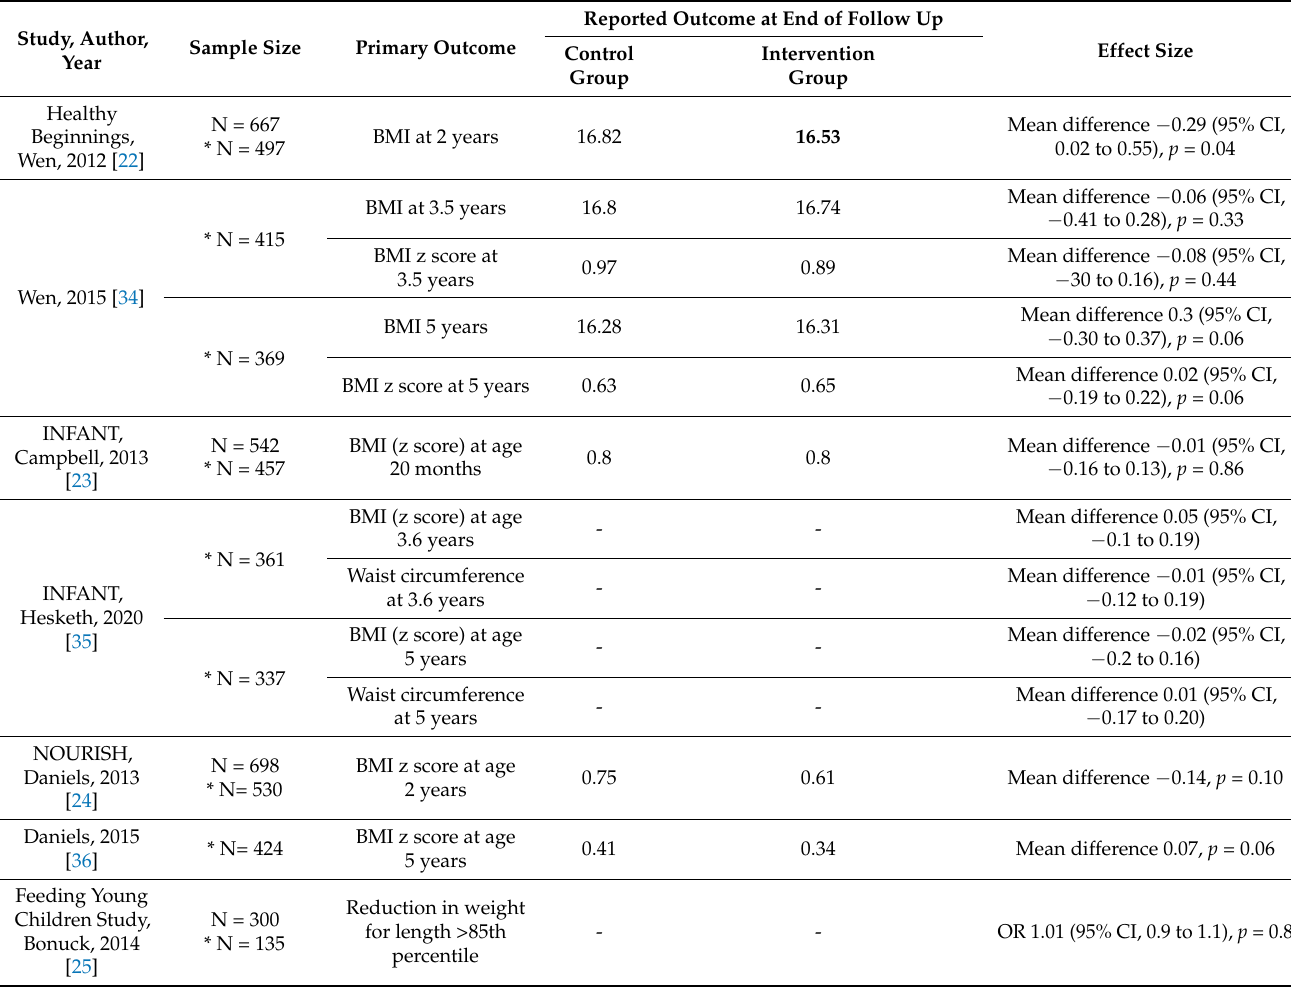
Table 4. Effect of trial interventions on weight outcomes in early intervention studies for the prevention of obesity in infancy. Study, Author,